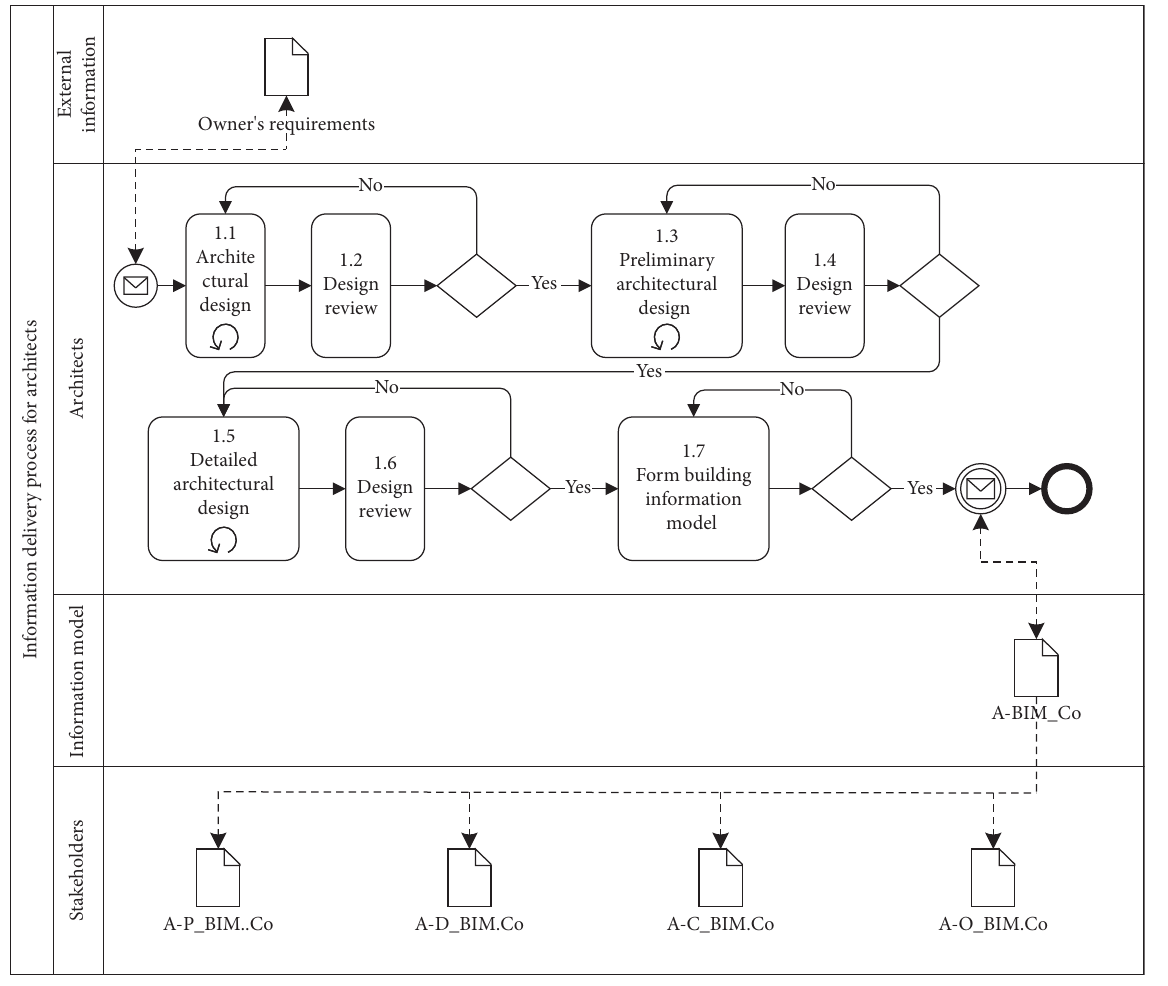
Figure 5: Information delivery process for architects. Table 1: A property set for IfcPrefabricate